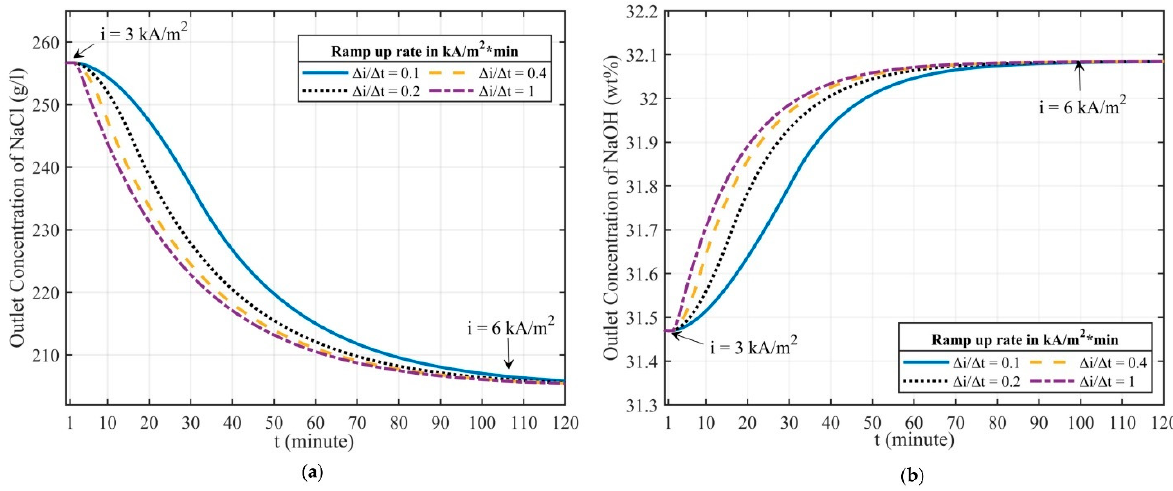
Figure 6. The outlet electrolytes concentration as a function of time in response to ramped up current density from 3 to 6 kA m − 2 at time, t = 1 min, with ramp rates of 0.1, 0.2, 0.4 and 1 kA m − 2 min − 1 . ( a ) Anolyte concentration and ( b ) catholyte concentration. Operating conditions: temperature: T in an = T in cat = 85 ◦ C; electrolyte concentration: X in = 300 gL − 1 and W in = 31 wt%; inlet volumetric flow rate: Q an = 5 L min cat = 6 L min